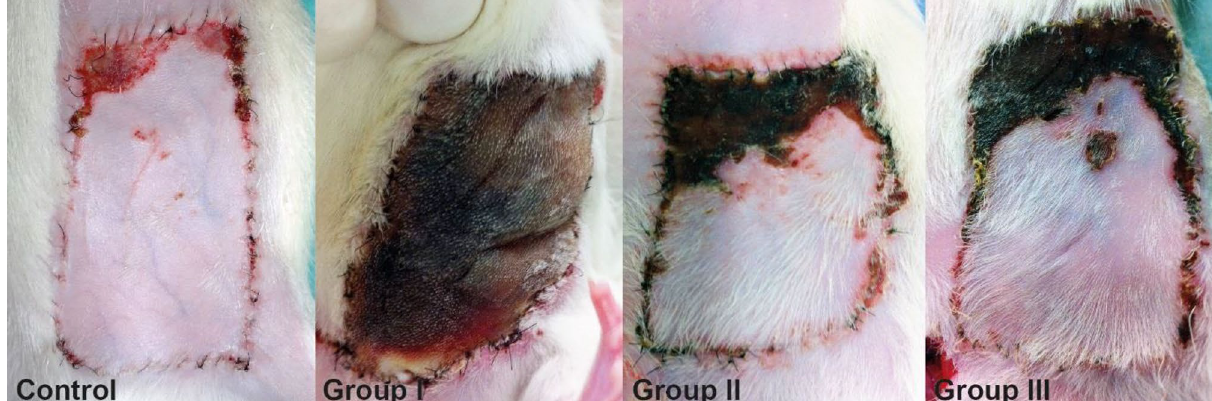
Figure 3. Flap survival. The mean survival rate in the control group was 89.3% ± 6.51%, total flap necrosis was found in group I, the mean survival rate in group II was 49.97% ± 24.34%, and that in group III was 64.95% ± 20.36%. In all groups, a necrosis pattern developed from mediocranial to laterocaudal, which corresponds with the findings of the perfusion pattern in ICG videoangiography (Fig.